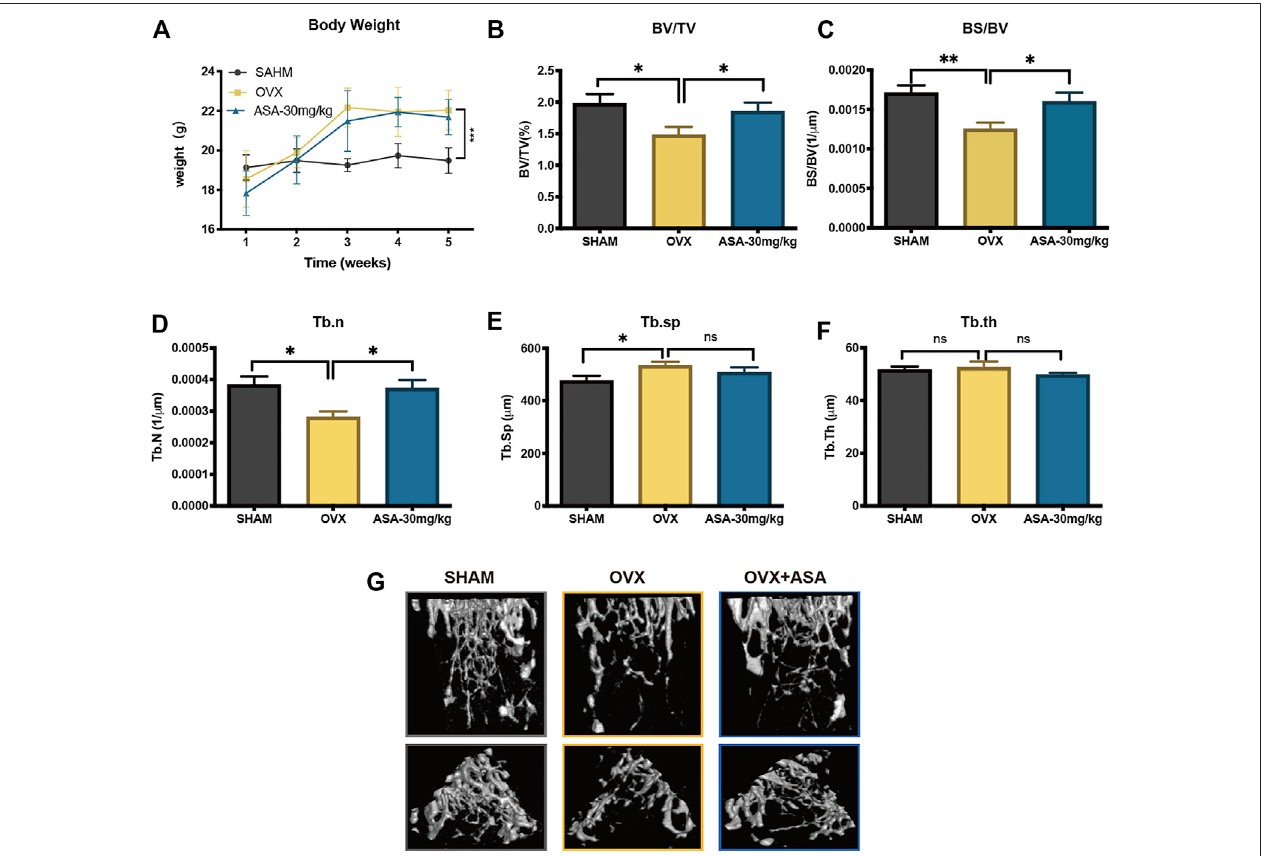
FIGURE 4 | Therapeutic effects of ASA on oestrogen-de fi ciency OP in vivo . (A) The dynamics bodyweight changes of all group in 4-weeks *** p < 0.001 vs control mice.Tibiasfrom all groups were analyzed by micro-CT. Bone parametersincluding (B) BV/TV (D) BS/BV (E) Tb. n (F) Tb. Sp (H) Tb. th of each sample were measured and calculated. n = 6. * p < 0.05 ** p < 0.01, *** p < 0.001 vs control mice. (G) The 3D reconstructed images of tibias from each group are shown. The images represent tibias (upper panel, front view; lower panel, top view) of SHAM, OVX and ASA (30 mg/kg) treated mice after 4-weeks